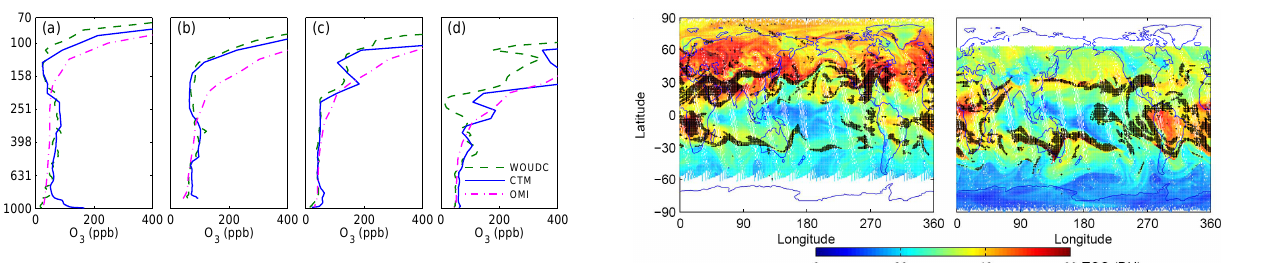
Fig. 1. O 3 profiles (unit: ppb) from WOUDC (dashed), CTM (solid) and OMI (dash-dot) as a function of pressure (unit: hPa). (a) Hong Kong (22.31 ◦ N, 114.17 ◦ E, STN 344), China, 7 Septem- ber 2005. (b) Ankara (39.97 ◦ N, 32.86 ◦ E, STN 348), Turkey, 17 August 2005. (c) Huntsville (34.72 ◦ N, 86.64 ◦ W, STN 418), AL,